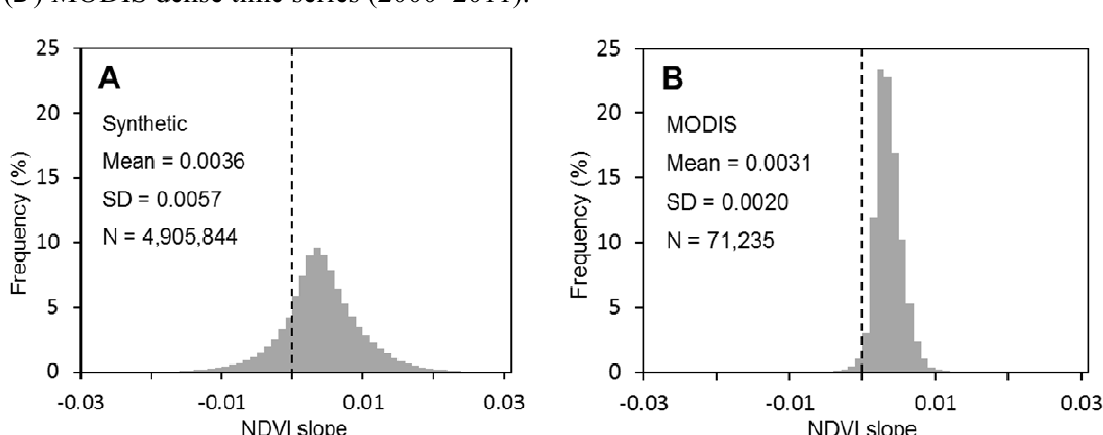
Figure 8. Histograms of the frequency of the NDVI slopes derived from ( A ) synthetic and ( B ) MODIS dense time series (2000–2011).